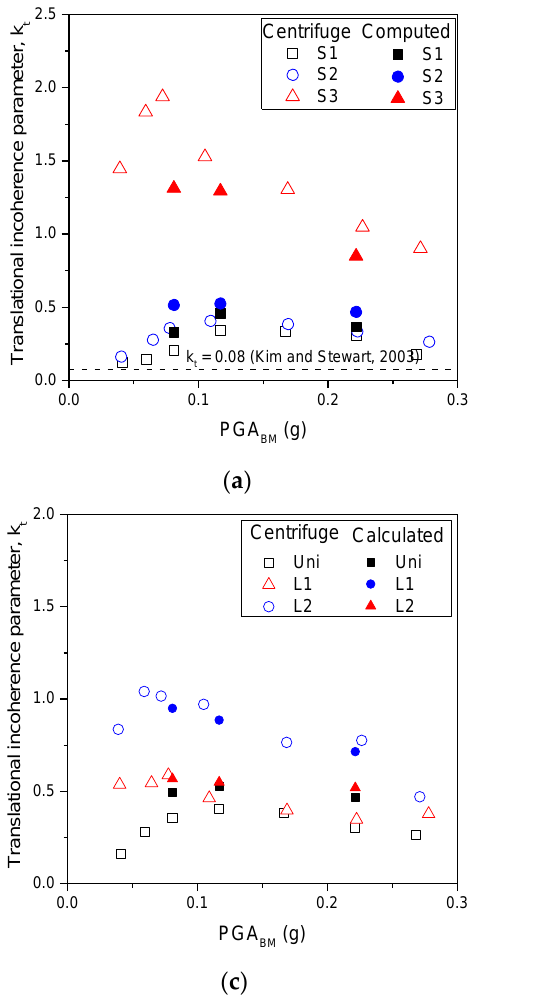
Figure 9. Translational transfer function between FM and FFM for the S1 structure at two levels of peak acceleration of the base motion (PGA BM ).